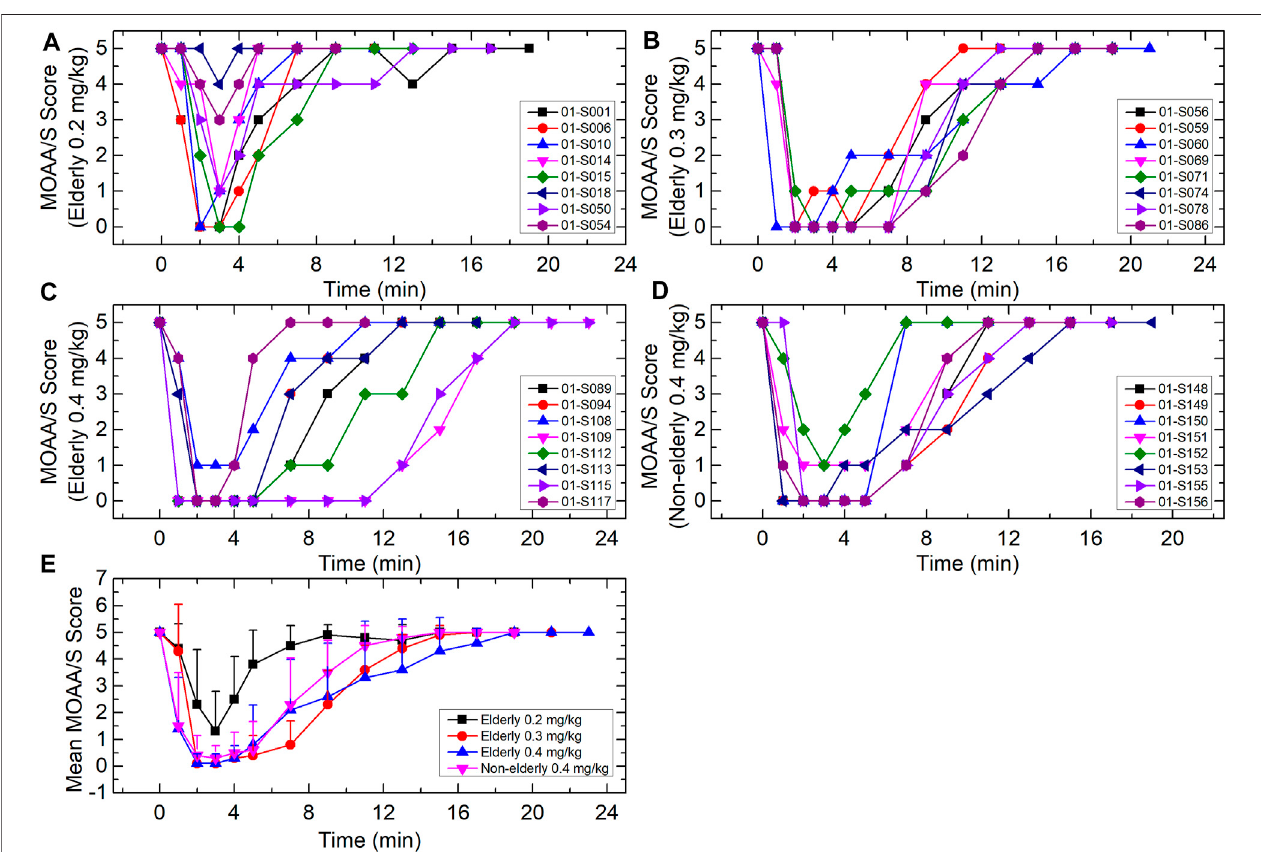
FIGURE 4 | MOAA/S score-time curves for (A) elderly 0.2 mg/kg; (B) elderly 0.3 mg/kg; (C) elderly 0.4 mg/kg; (D) non-elderly 0.4 mg/kg; and (E) mean for each group. Data are reported as mean + standard deviation for (E) .